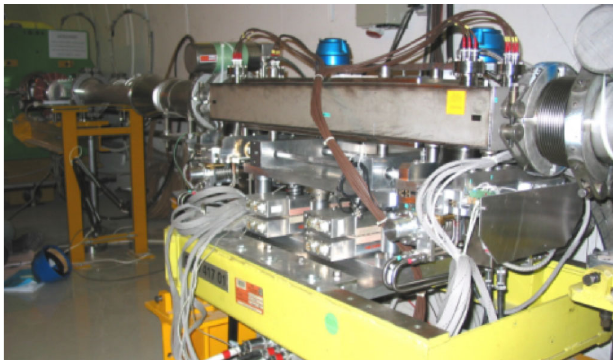
FIG. 3. (Color) The installation of the prototype LHC collimator in the SPS tunnel. The figure is taken from [31].